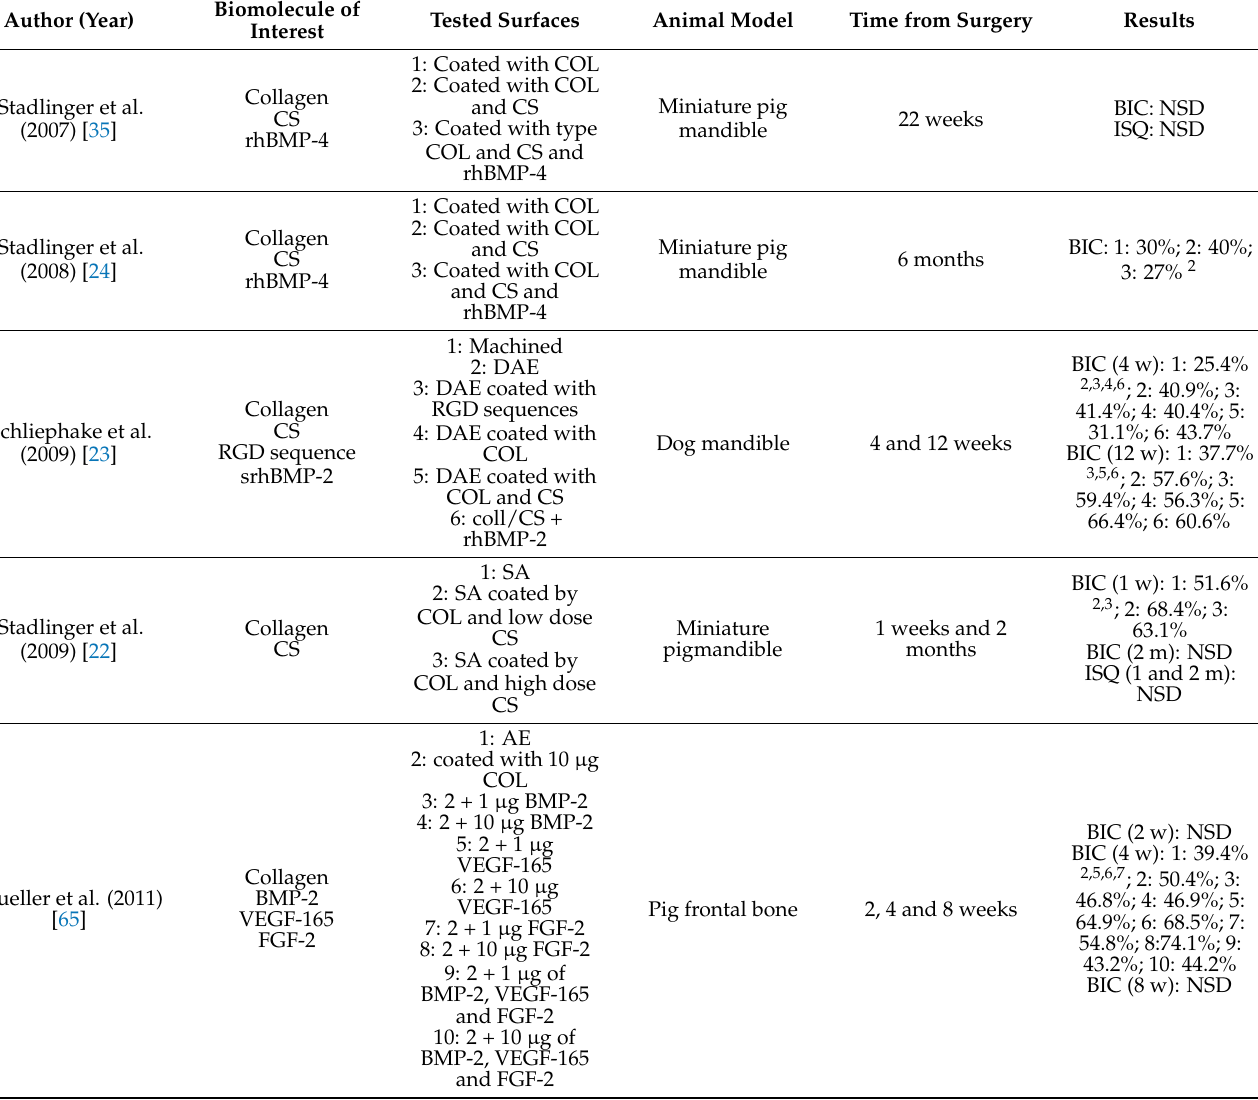
Table 6. Combinations of collagen and glycosaminoglycans or growth factors: results from the considered studies. Author